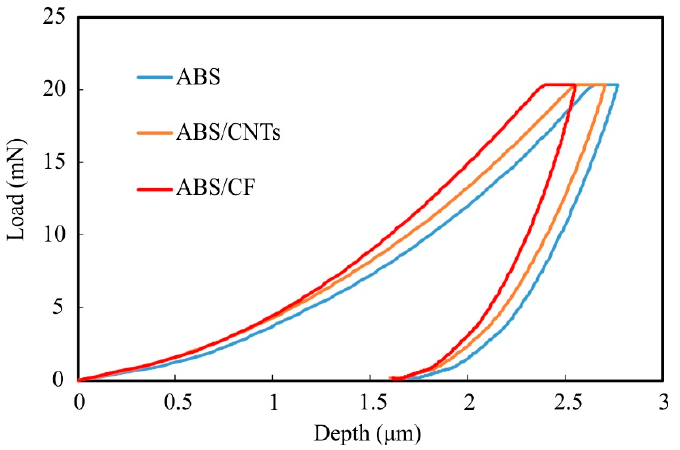
Figure 5. Load-depth curves of ABS, ABS/CNT and ABS/CF Fused Filament Fabrication (FFF) printed specimens. Table 1. Compressive and nanoindentation properties of the ABS, ABS/CNT and ABS/CF speci- mens.